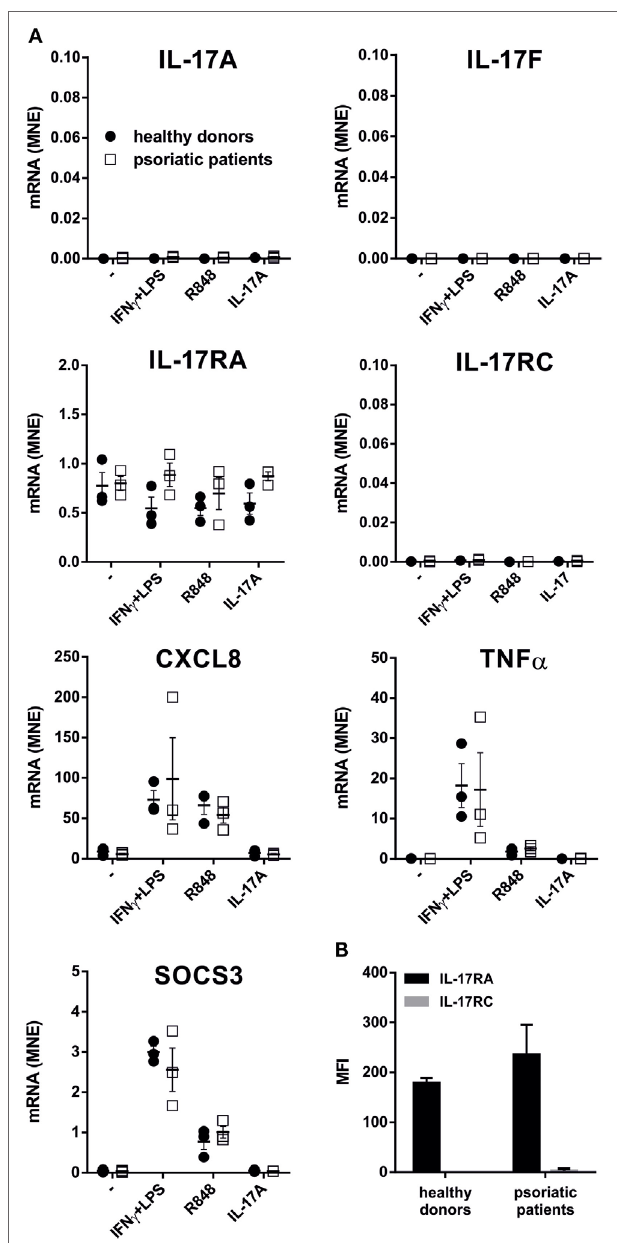
FigUre 7 | IL-17A, IL-17F, IL-17RA, IL-17RC, CXCL8, TNF α , and SOCS3 mRNA expression, as well as IL-17R surface expression, in neutrophils from patients with psoriasis. (a) Neutrophils isolated from healthy donors (HDs) ( n = 3) or psoriatic patients ( n = 3) were cultured for 20 h with 100 U/ml IFN γ plus 100 ng/ml LPS, 5 µM R848, or 500 ng/ml IL-17A to evaluate IL-17A, IL-17F, IL-17RA, IL-17RC, CXCL8, TNF α , and SOCS3 mRNA expression by reverse transcription quantitative real-time PCR. Gene expression data are depicted as mean normalized expression (MNE) units after GAPDH mRNA normalization. (B) Surface IL-17RA and IL-17RC expression evaluated by flow cytometry in human neutrophils from HDs or psoriatic patients. Values represent the mean ± SEM ( n = 3). For the data of panels (a,B) no significant differences between HDs or psoriatic patients were observed by two-way ANOVA followed by Bonferroni’s